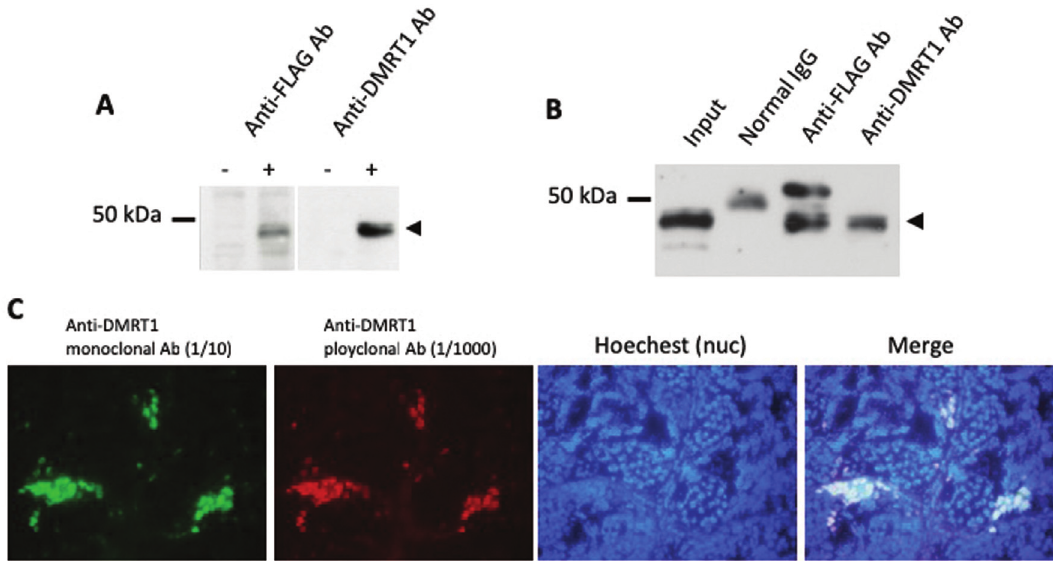
Figure 1 - Immunoreaction of an anti-DMRT1 monoclonal antibody 4F6 against X. laevis DMRT1. (A) Immunoblot analysis using the anti-FLAG (M5) or anti-DMRT1 (4F6) monoclonal antibodies. pcDNA3-FLAG or pcDNA3-FLAG-DMRT1 was transiently transfected into 293T cells. Extracts of 293T cells were examined by immunoblotting with each antibody followed by a HRP conjugated anti-mouse IgG antibody. DMRT1 was detected as a single bandatthesamesizebybothantibodies(arrowhead).(B)Immunoprecipitation(IP)analysiswiththeanti-FLAG(M5)oranti-DMRT1(4F6)monoclonal antibodies.pcDNA3-FLAG-DMRT1wastransientlytransfectedinto293Tcells.Thecelllysatewasmixedwitheachantibodyandpulleddownwithpro- tein A/G agarose. IP extracts were examined by immunoblotting using the anti-DMRT1 polyclonal antibody followed by a HRP conjugated anti-rabbit IgG antibody. (C) Immunohistochemical analysis using the anti-DMRT1 monoclonal antibody 4F6 (1/10) and anti-DMRT1 polyclonal antibodies (1/1000) . Frozen sections of adult testis were stained with Hoechst 33258 for nuclei and reacted with both the antibodies, followed by Alexa 594-conjugated anti-mouse (red) and Alexa 488 anti-rabbit-IgG (green) antibodies. Both signals showed the same staining